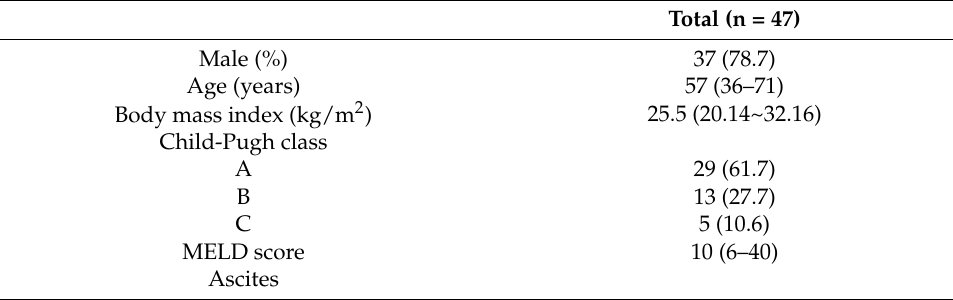
Table 1. Baseline characteristics of recipients that underwent